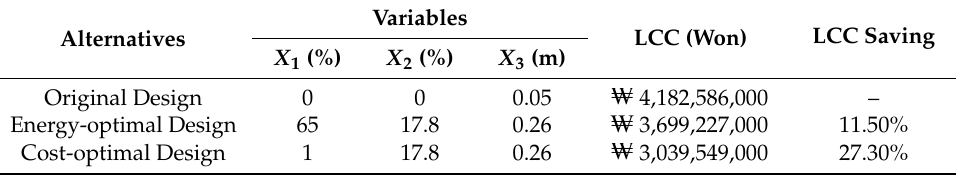
Figure 12. Comparison Results of Alternatives. Table 5. Results of Case Study.